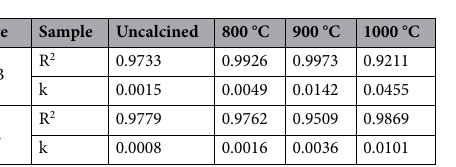
Figure 4. Photocatalytic experiments of MB ( a , b ,) and CR ( c,d ,) with calcined catalysts at different temperatures: ( a , c ) curve of removal rate with time, ( b , d ) plot of log of concentration with time. Photodegradation absorption spectra of ( e ) MB and ( f ) CR solutions in the presence of clam shell powder calcined at 1000 °C.